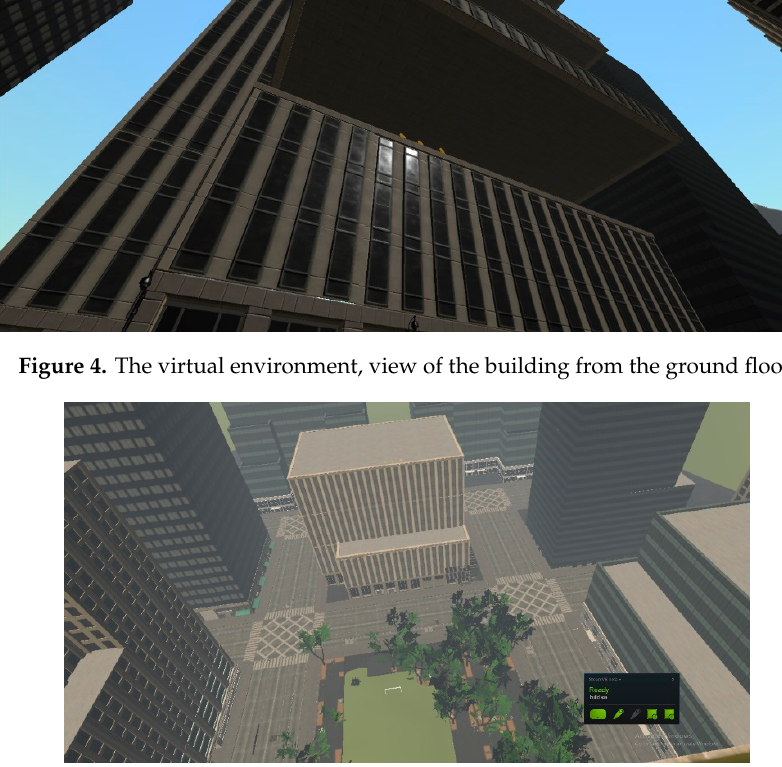
Figure 5. The view from the building’s rooftop.